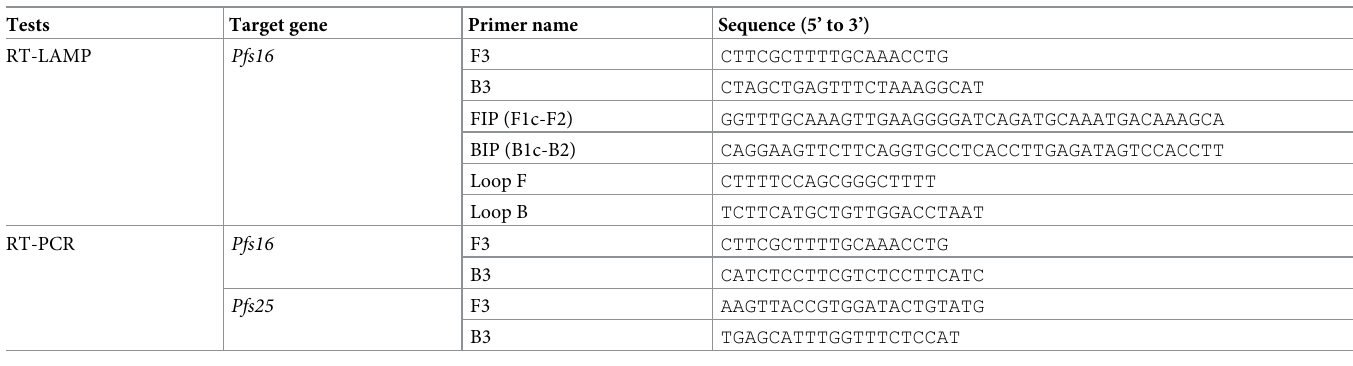
Table 1. RT-LAMP and RT-PCR primer sequences.